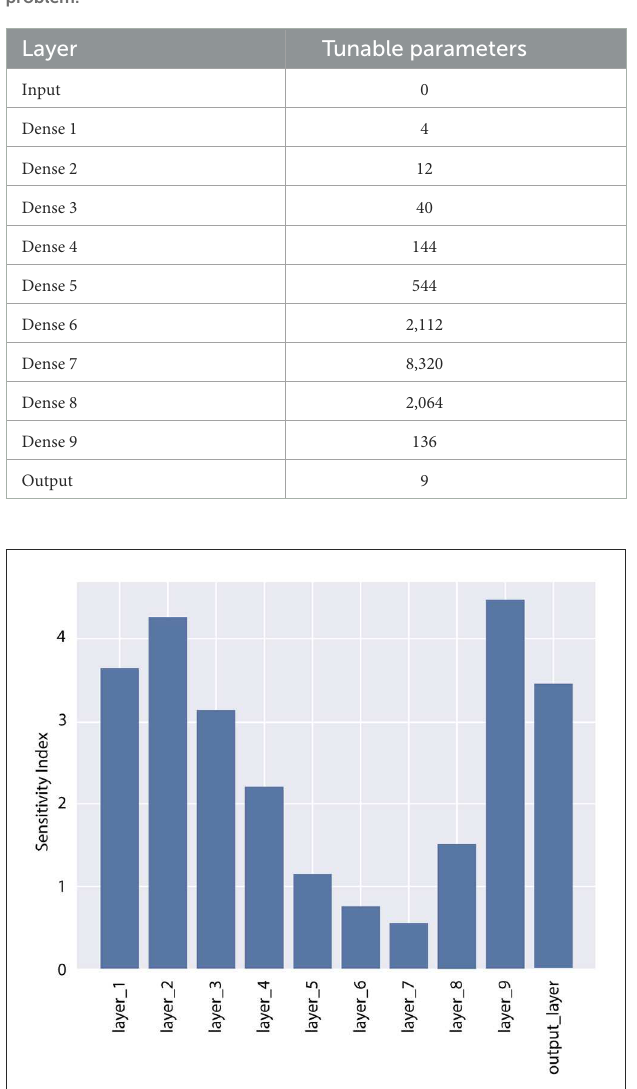
FIGURE2 Sensitivity Index (SI) for all layers in the DNN for the test problem. Layer 9 has the highest SI and is selected for Bayesianization.